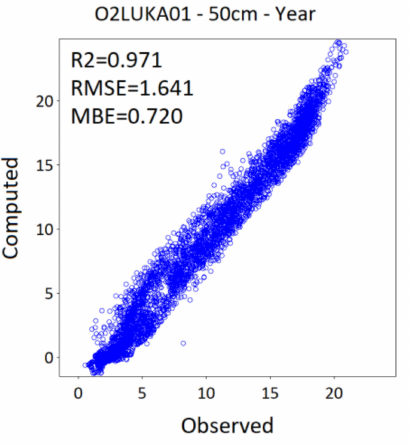
Figure A14. Validation at site O2LUKA01 for 50 cm soil